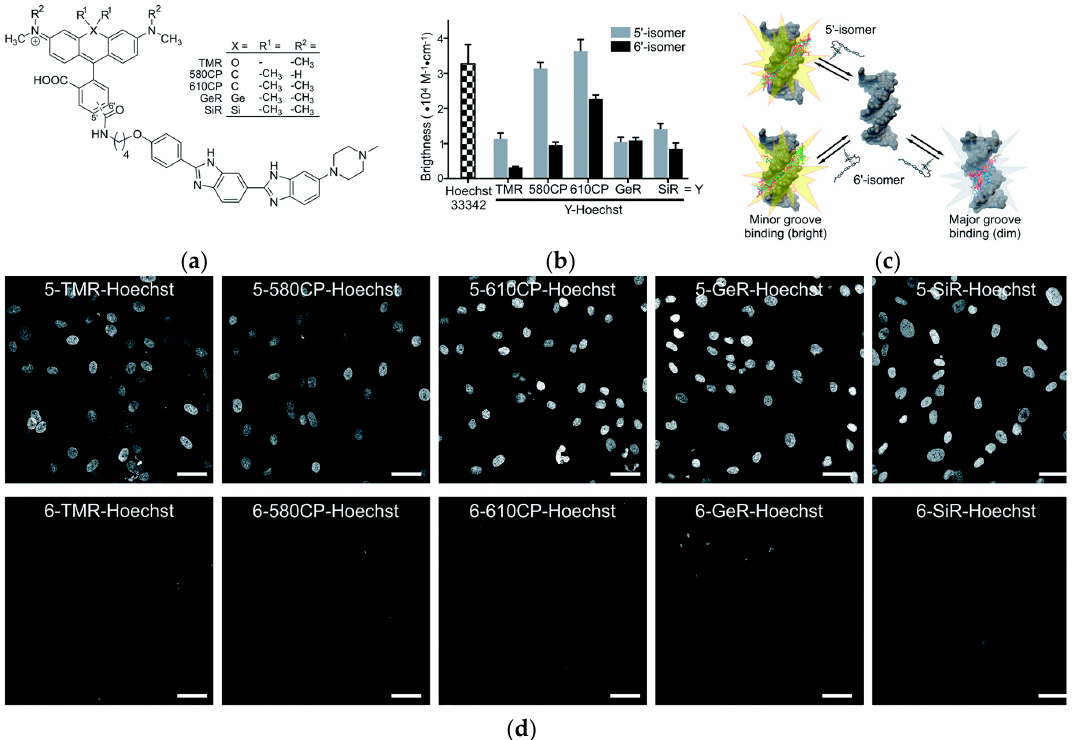
Figure 9. Novel dyes for the staining of chromatin: ( a ) Structures of the Hoechst derivatives; ( b ) the brightness after binding to specific DNA; ( c ) the proposed model of rhodamine–Hoechst conjugate interaction with the target DNA; ( d ) Representative confocal images of human fibroblasts stained with different 5 ′ - and 6 ′ -Hoechst dyes. Adapted with permission from [135]—Published by The Royal Society of Chemistry. Scale bars = 50 µm.